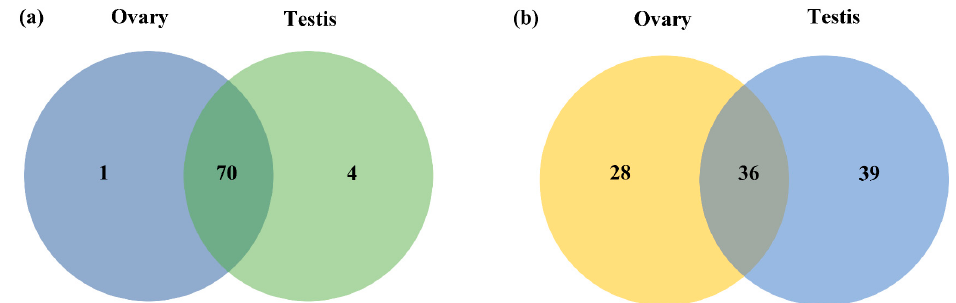
Figure 2. Overview of miRNAs identified from the transcriptome. ( a ) Distributions of known miRNAs between the ovary and the testis. ( b ) Distributions of novel miRNAs between the ovary and the testis.